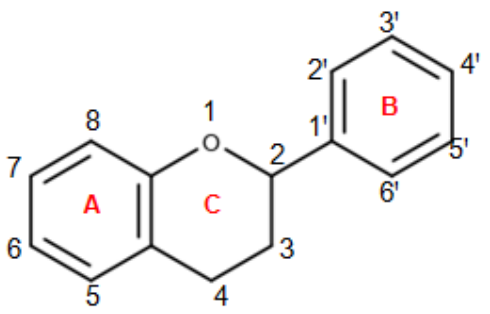
Figure 2. Chemical classification of polyphenols.